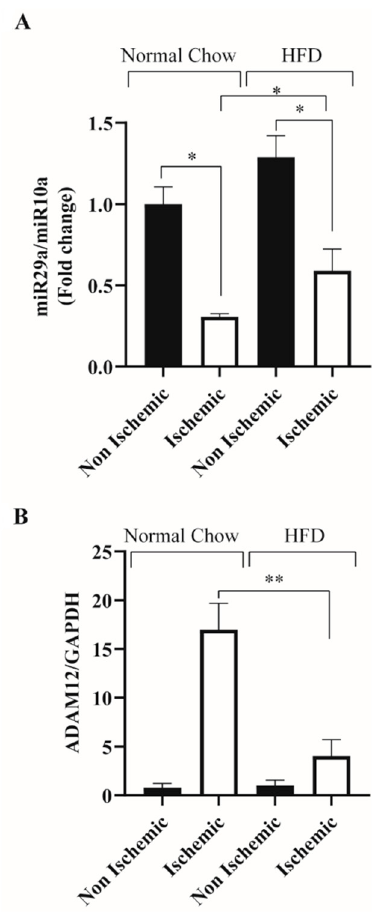
Figure 1. HFD feeding impairs miR-29a downregulation and ischemia induced ADAM12 upregu-